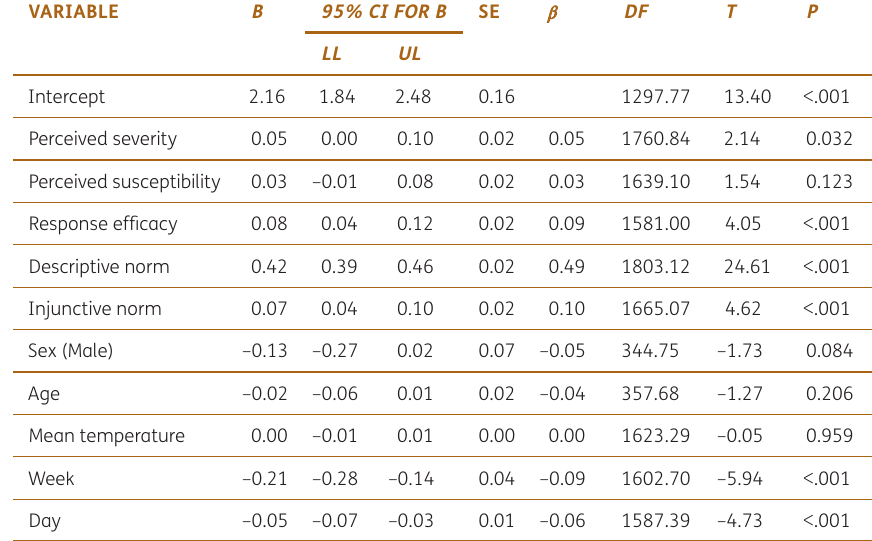
Table 2 Multivariate Linear Mixed-Effects Model Predicting Physical Distancing Behavior in the School Sample. Note : N = 375 . ICC = .46. Marginal R 2 = .44. Conditional R 2 = .69. Participant